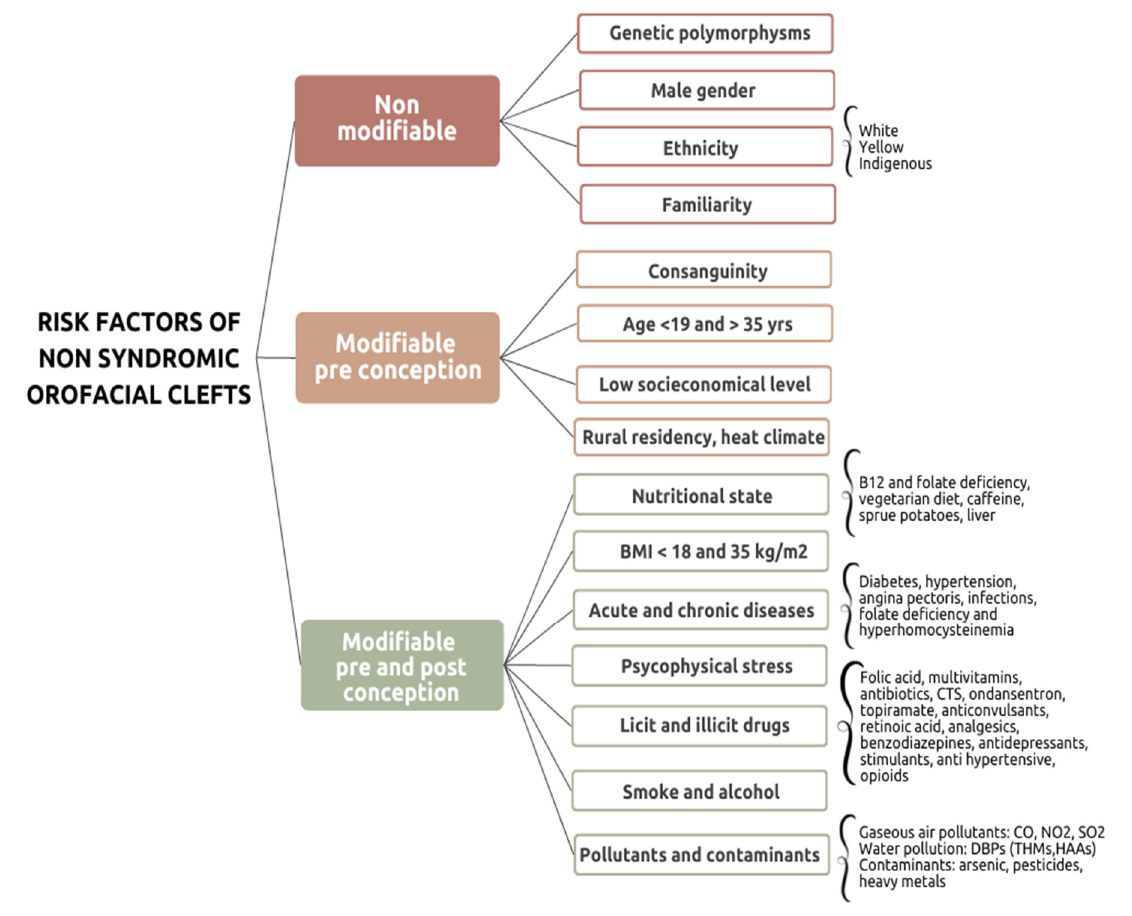
Figure 3. Overview of non-modifiable and modifiable risk factors of NSOFCs [CO: carbon monoxide; CTS: corticosteroids; DBPs: water disinfection By-products; HAAs: haloacetic acids; NO 2 : nitrogen dioxide; SO 2 : sulfur dioxide; THMs: trihalomethanes]. In NSOFCs, genetic polymorphisms belong predominantly to the folate pathway.